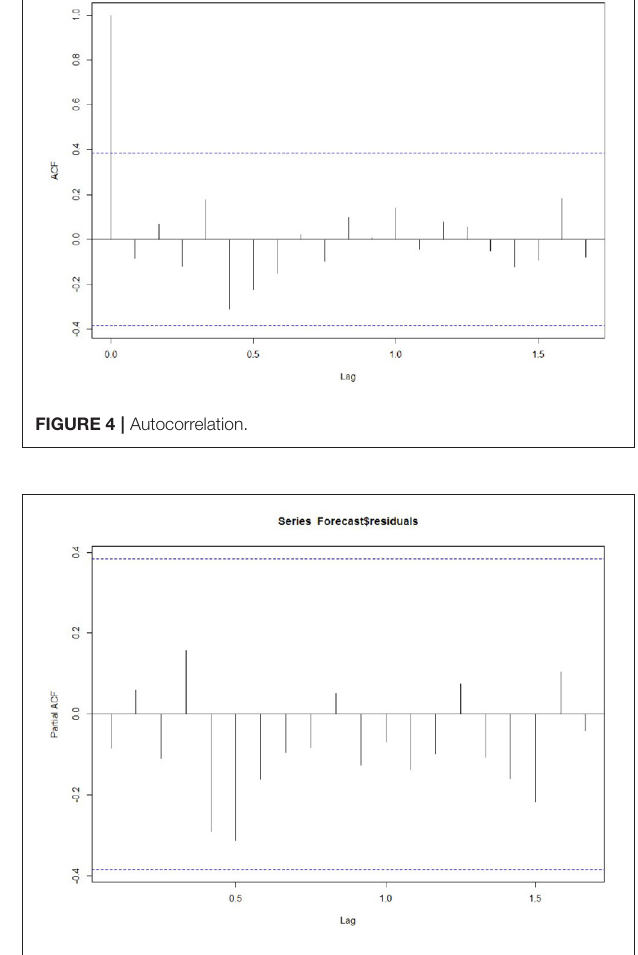
FIGURE 5 | Partial correlation